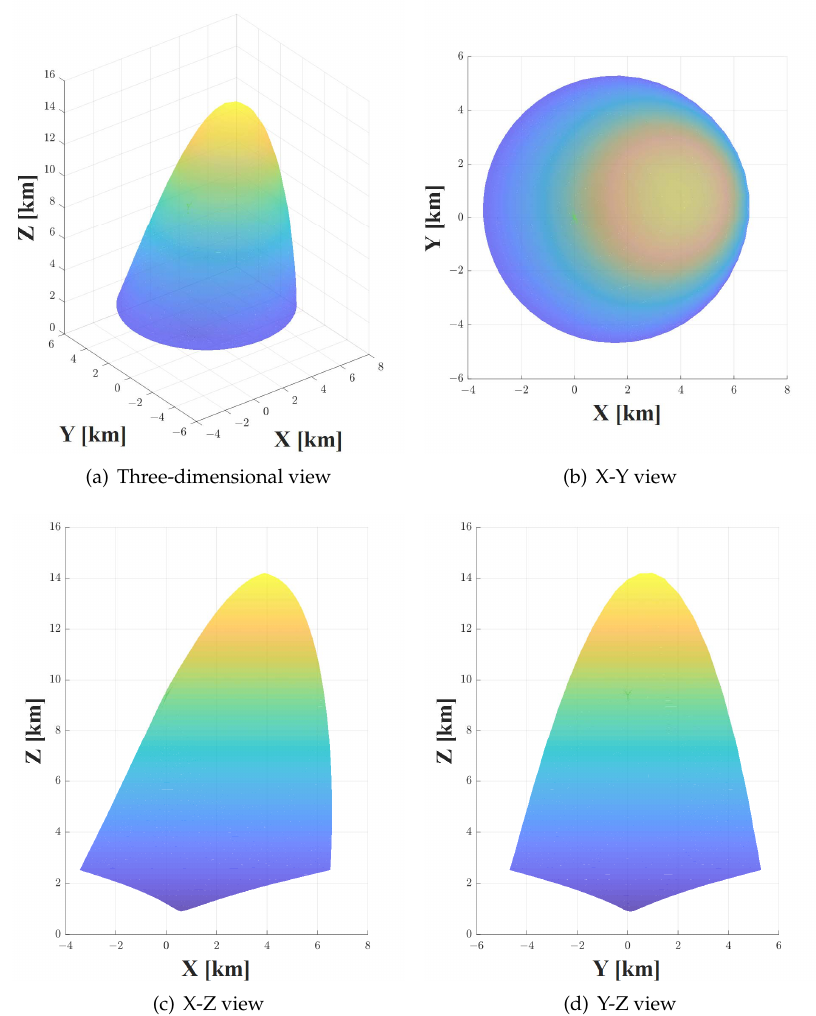
Figure 12. Controllability set of Example